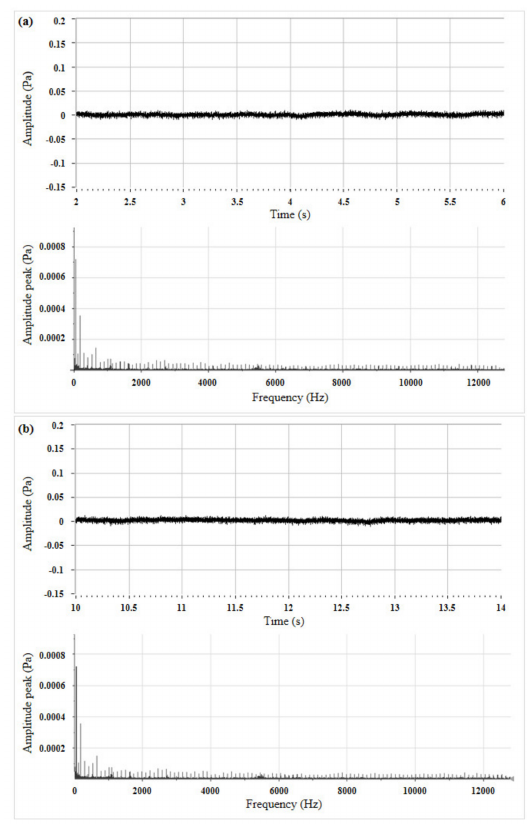
Figure 11. Sound pressure and frequency. ( a ) Water only; ( b ) failure case.